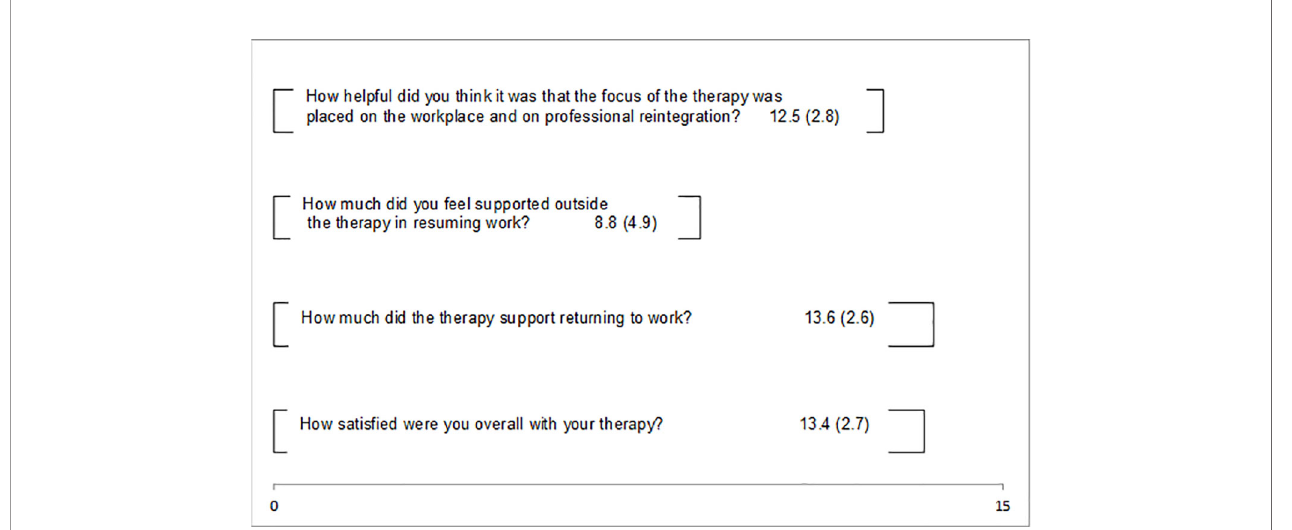
FIGURE 1 | Results of the acceptability questionnaire in